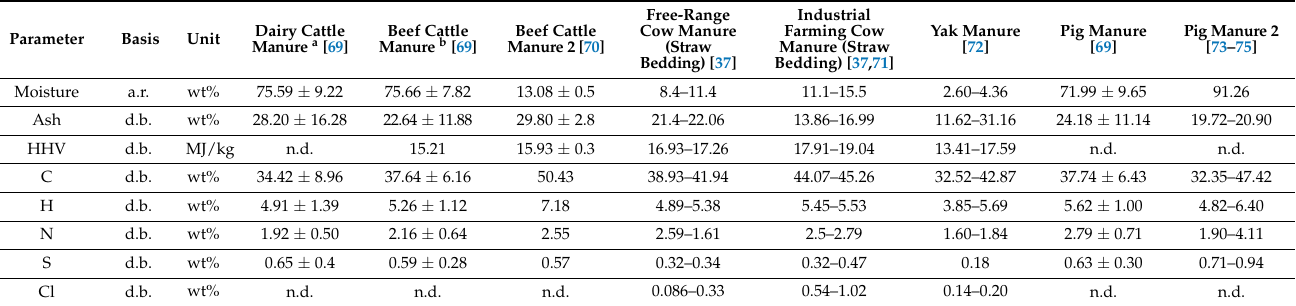
Table 2. Proximate and elemental (ultimate) analysis of cow (cattle) and piggery (swine) manure (a.r.—as received, d.b.—dry basis, and n.d.—no